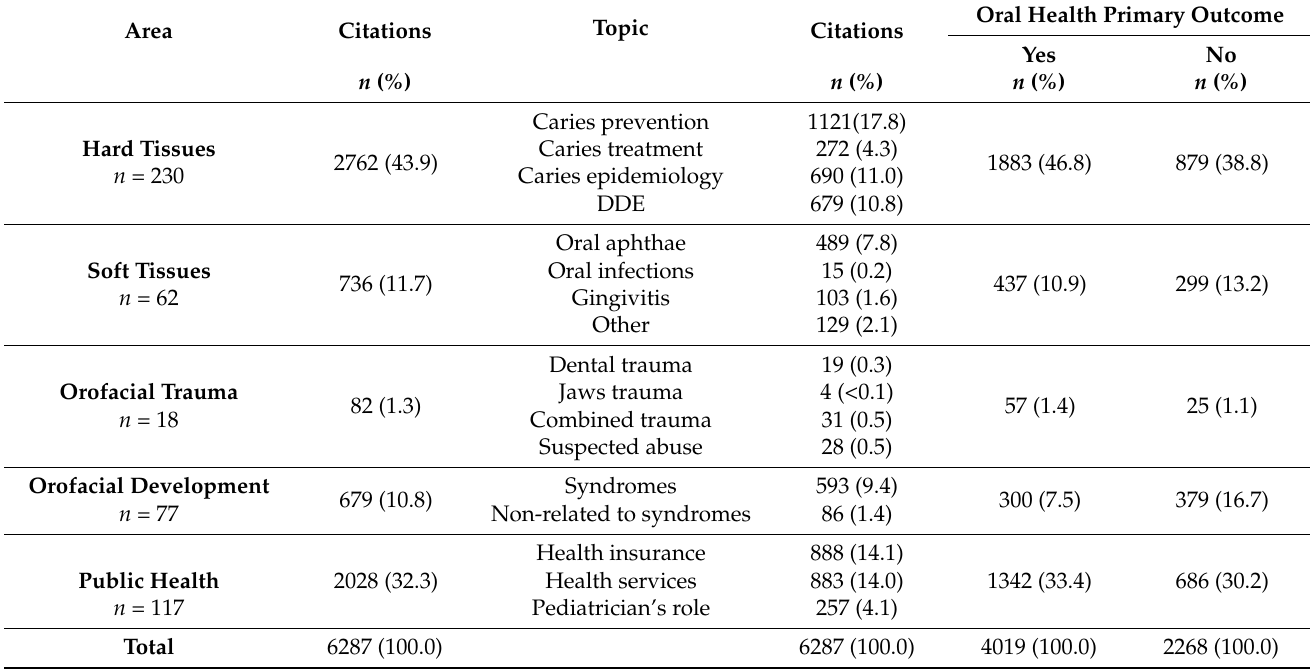
Table 3. Citations of the included papers by area, topic, and the primary or not primary